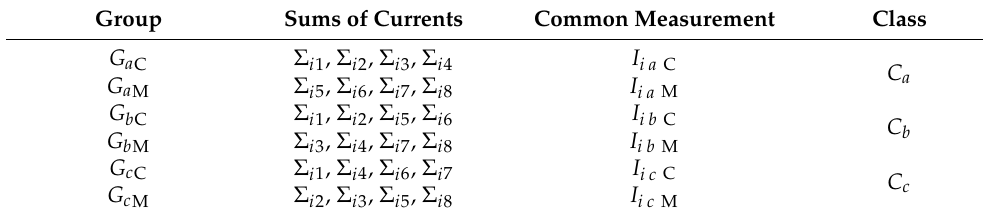
Table 4. Currents Monitor: groups and classes for FDI of sensors and coil faults to the i -th motor.